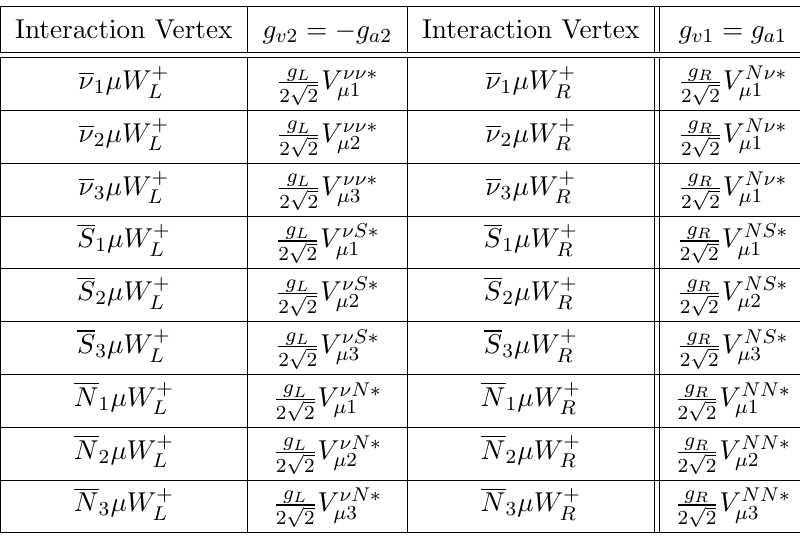
Table 4 . Relevant vector and axial vector couplings for muon with W L ; W R gauge bosons and physical neutral fermion states within the extended inverse seesaw (EISS) scenario.